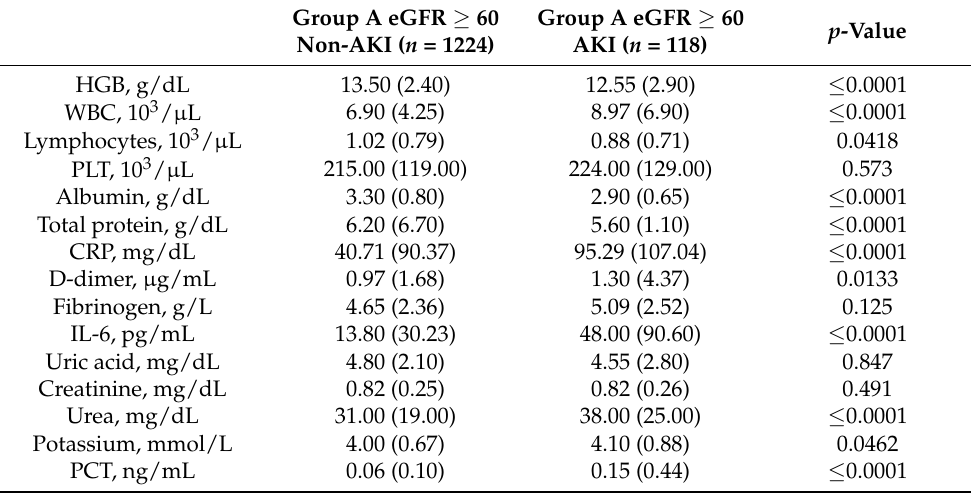
Table 10. Laboratory values of patients with eGFR ≥ 60 mL/min/1.73 m 2 at admission without and with AKI during